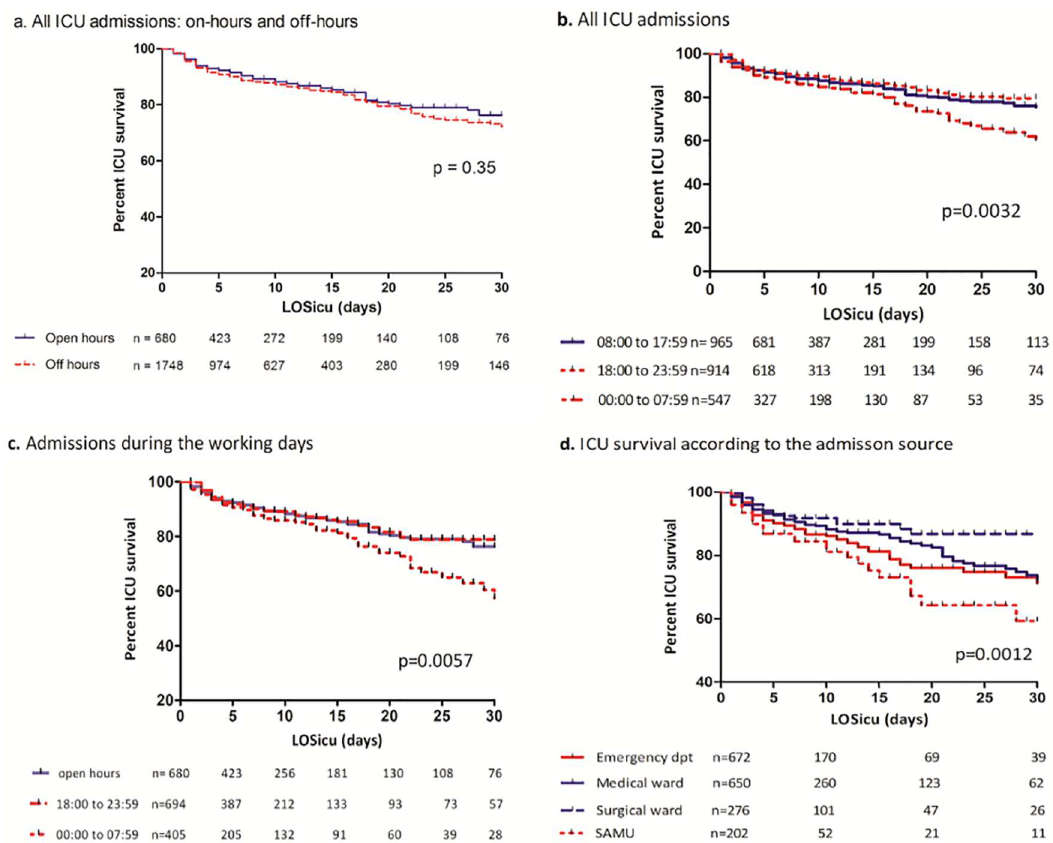
Fig 2. Kaplan–Meier curves of ICU survival according to the time and source of admission. Comparison of ICU survival of patients admitted duringon-hoursand off-hours (a) and of patients admitted from 08:00 to 17:59, 18:00 to 23:59, and 00:00 to 07:59 (b) . Comparisonof ICU survival of patients admitted duringweekdaysaccordingto time period of admission (c) . Comparison of ICU survival accordingto the source of admission (d) . LOSicu: lengthof stay in the ICU.